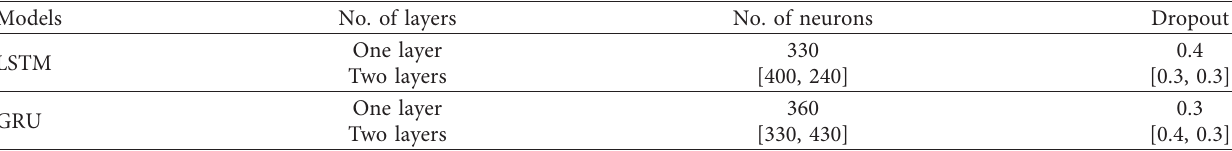
Table 8: The best value parameters of DL for death cases in Saudi Arabia.